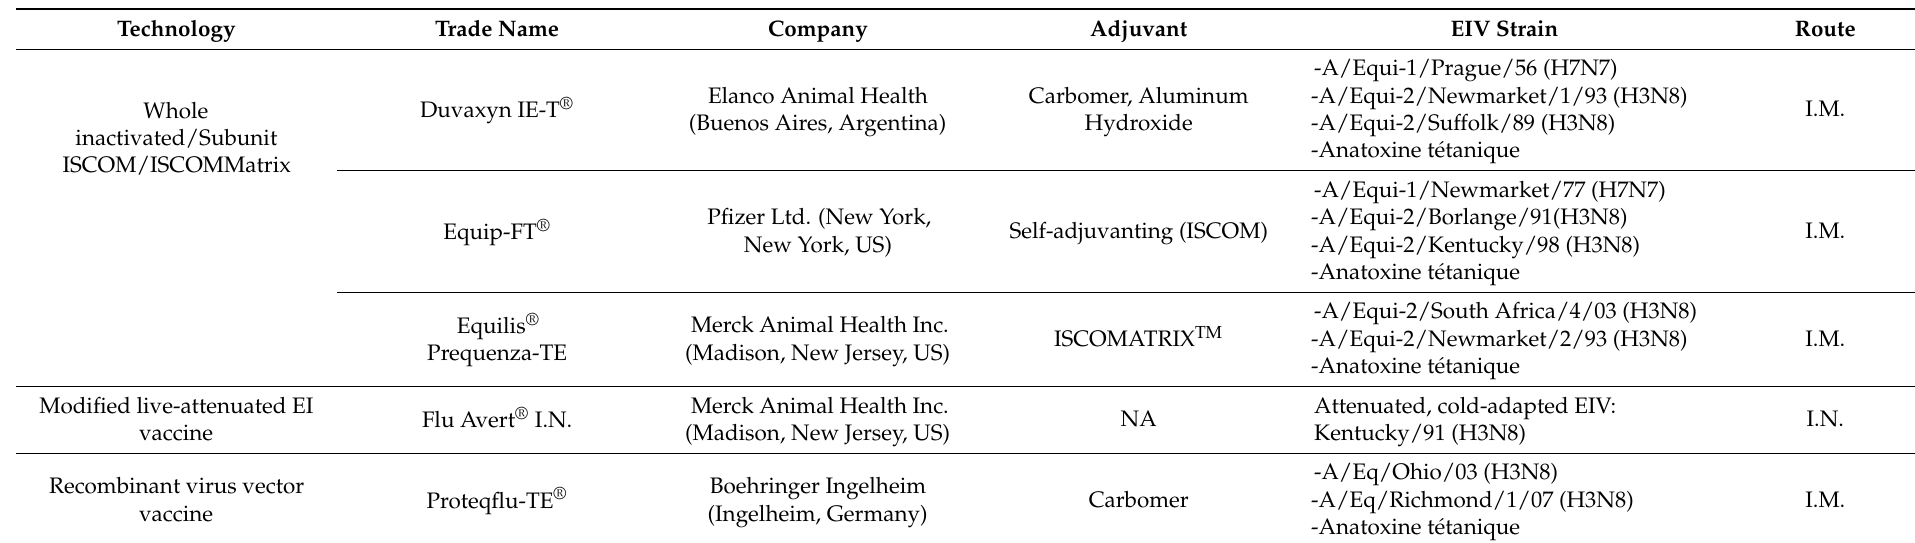
Table 3. Selected examples of commercially available EI vaccine